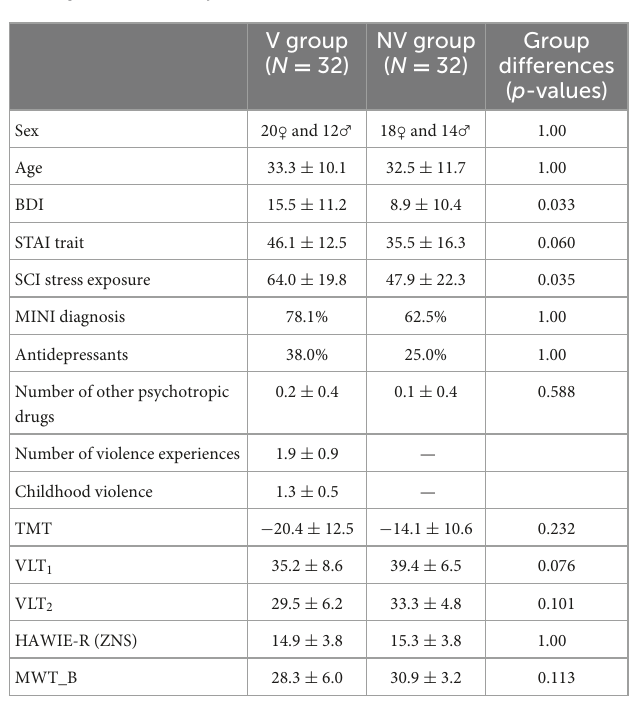
TABLE 2 Sample characteristics for victims of violence (V) and non-victims (NV): Binary variables (sex, MINI diagnosis, and antidepressants): Statistical comparison of groups performed via chi-square test of independence; Continuous variables: mean ± standard deviation, statistical comparison of groups performed via independent two-sample t -test for normally distributed features [STAI trait, TMT, VLT 2 , HAWIE-R (ZNS)] and Mann Whitney U -test for non-parametric